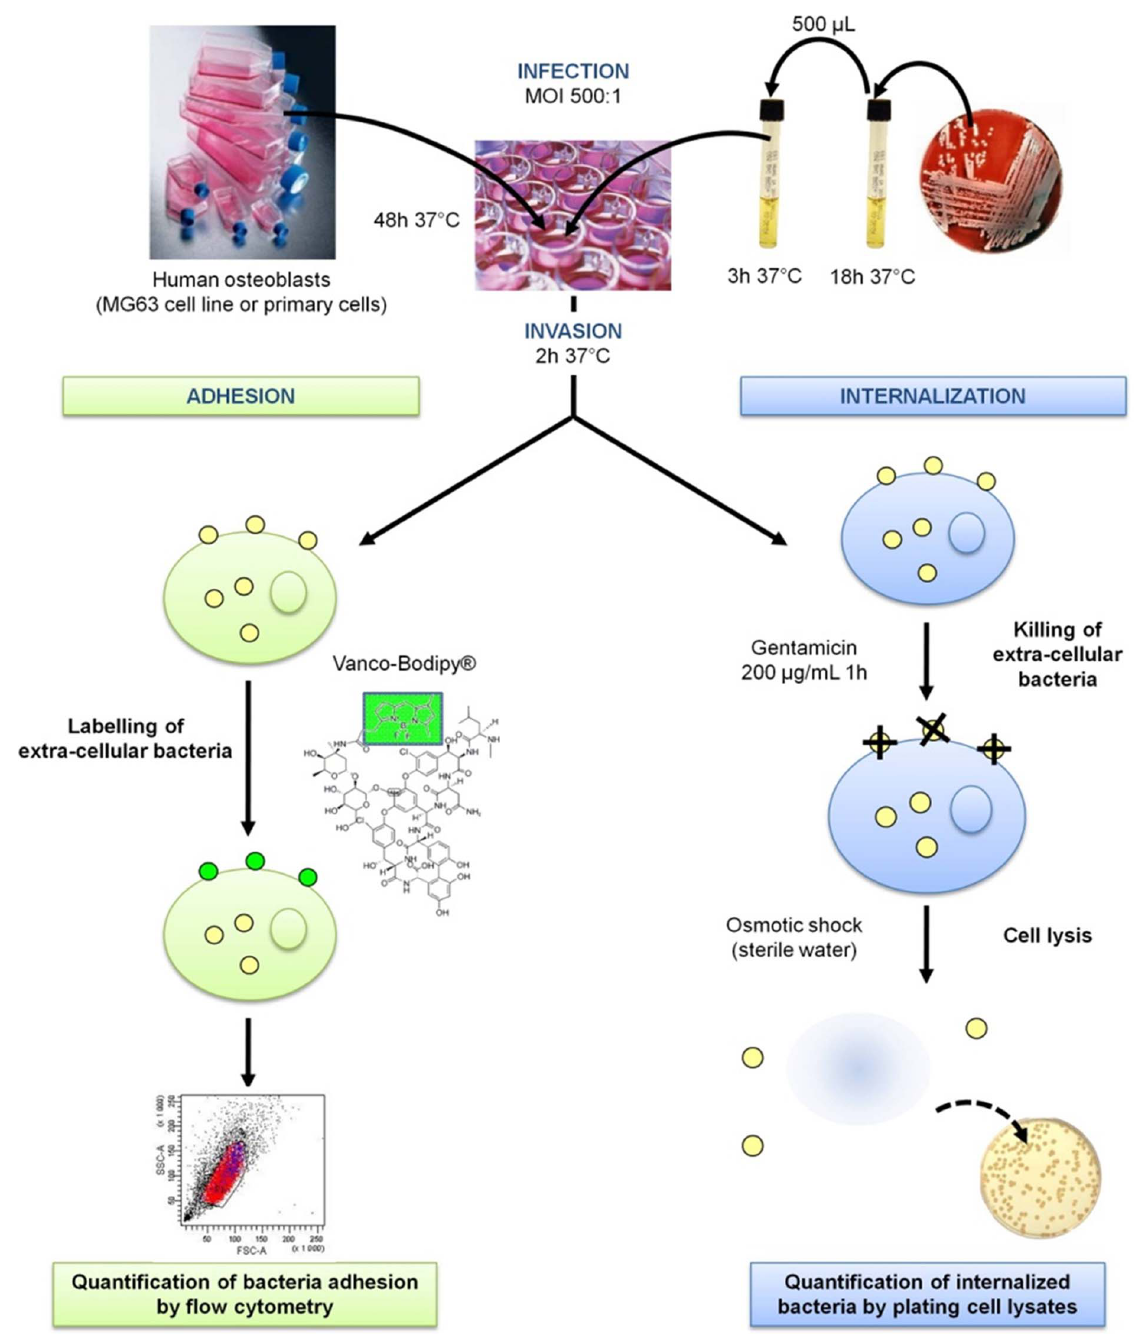
Figure 1. Gentamicin protection assay. MOI: Multiplicity of infection. (negative control). The total number of bacteria was estimated as the mean fluorescence intensity of cells in M multiplied by the proportion of cells in M, which is represented in arbitrary fluorescence units (AFU) [13].